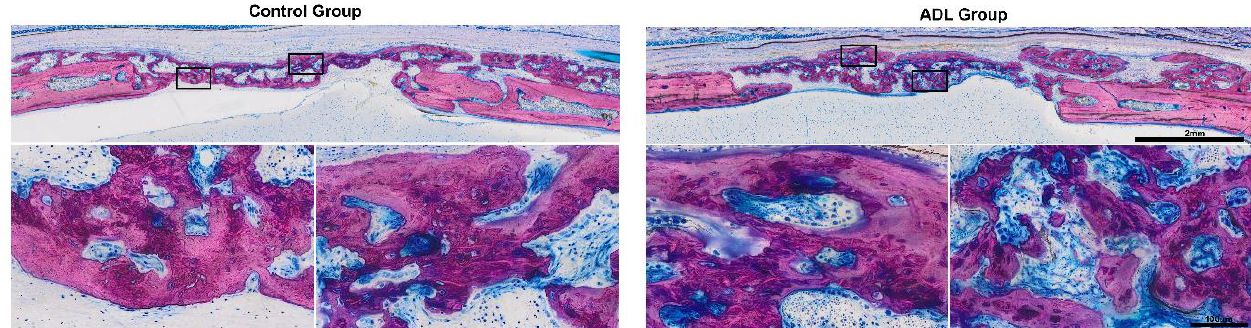
Figure 5. Detailed overview on the new bone in the control group and in the acid dentin lysate (ADL) group. Note the characteristic features of immature woven bone indicated by the intense purple stain and the large osteocyte lacunae. The dense part of the membrane is visible in the upper part of control group also showing that new bone grows on the collagen membrane.